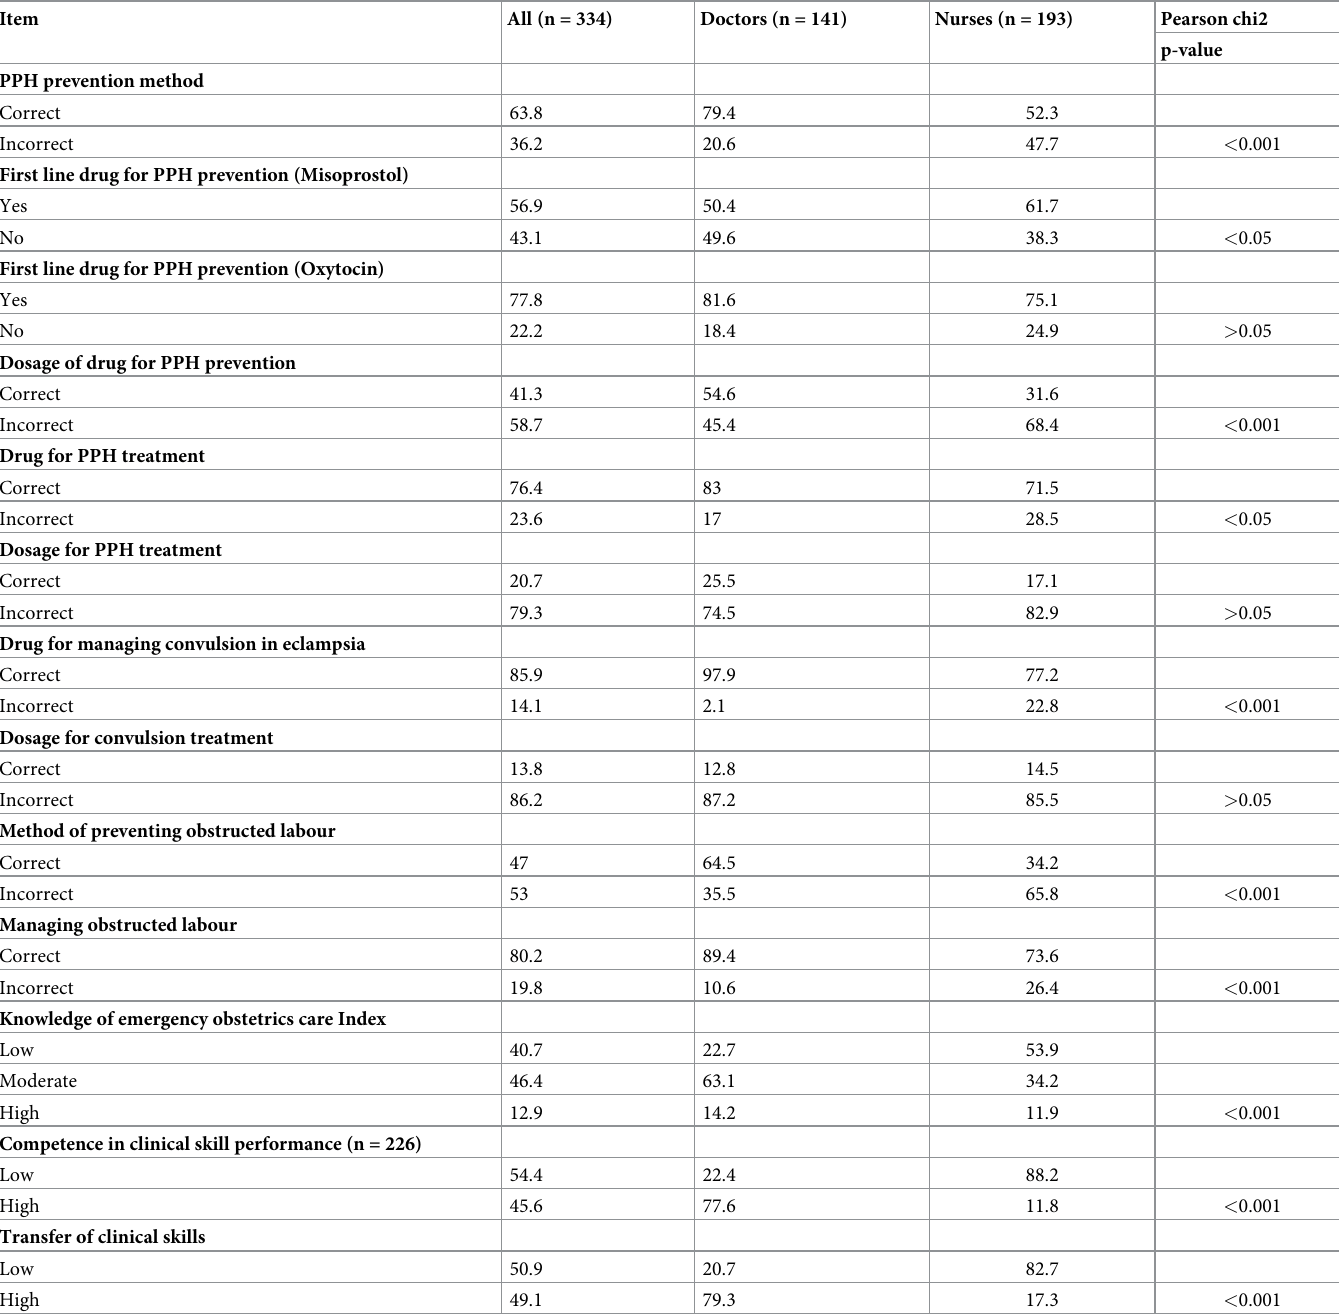
Table 3. Knowledge of emergency obstetric care (WHO recommended standard), competence and transfer of clinical skills.